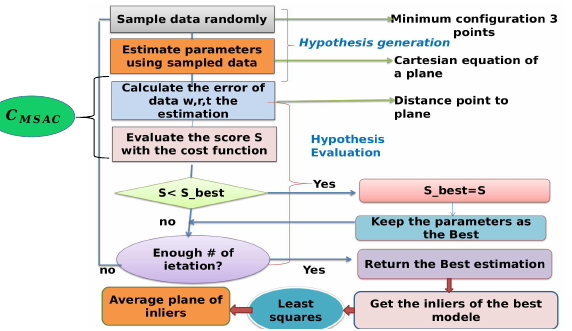
Figure 7. Robust estimation of a plane using MSAC